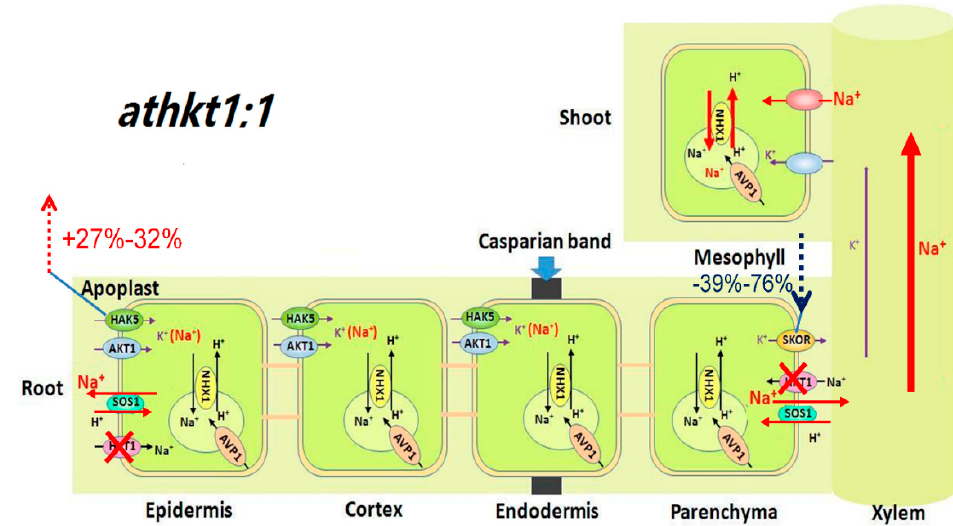
Figure 7. Schematic model for the function of AtHKT1;1 and AtSOS1 in regulating K + and Na + transport in athkt1;1 of A. thaliana under saline conditions. For the plants growing in 25 mM NaCl, mutation of AtHKT1;1 interdicted Na + unloading from the xylem to the xylem parenchyma cells (XPCs). Compared with WT, loss-of-function of AtHKT1;1 induced a 39–76% (6–24 h) decrease in transcripts of AtSKOR in the roots, At the same time, 25 mM NaCl induced a 27–32% (6–24 h) increase in transcripts of AtHAK5 in the roots, Consequently, Na + was loaded into the xylem and delivered to the shoots, whereas K + was restricted.